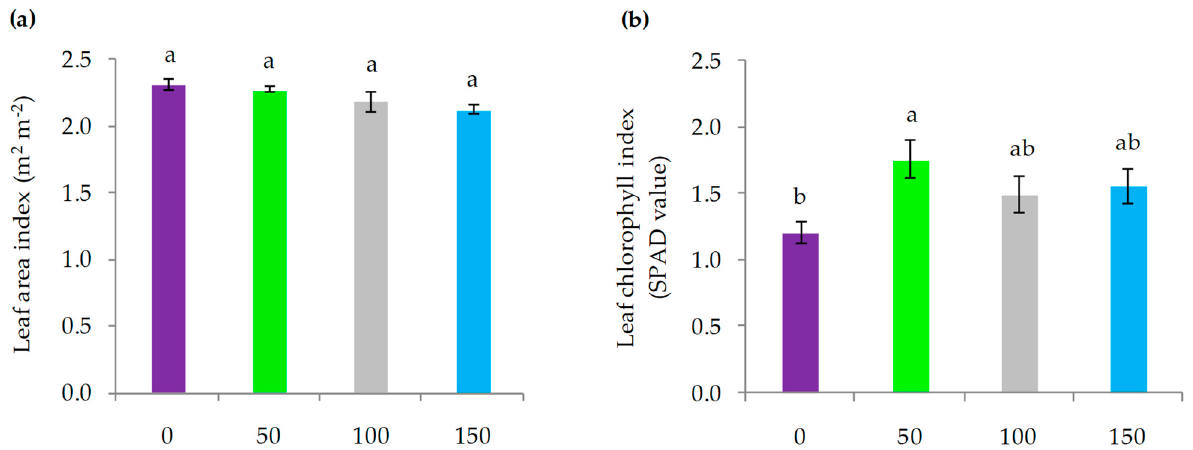
Figure 5. ( a ) Leaf area index values recorded in calafate plants; ( b ) leaf chlorophyll index recorded in calafate leaves subjected to different doses of water replenishment. Treatments: 0%, 50%, 100% and 150% ET 0. Different lowercase letters indicate significant differences between treatments according to Fischer’s LSD test ( p < 0.05). Mean ± standard error ( n = 4). Bars correspond to experimental error for each treatment.